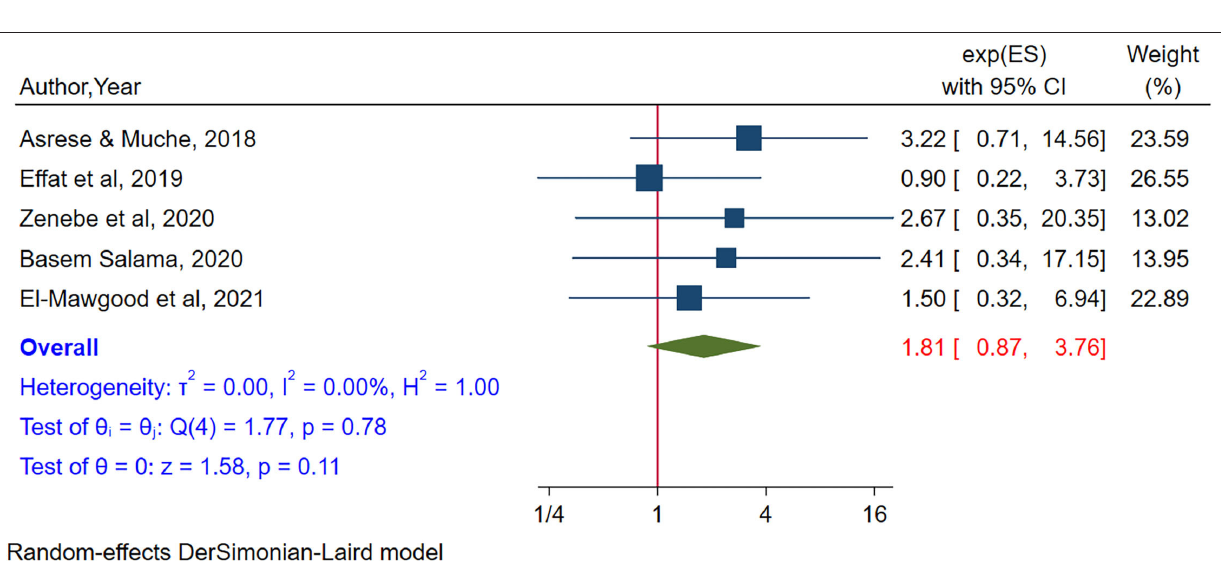
FIGURE 7 | The pooled association between gaming and internet addiction.